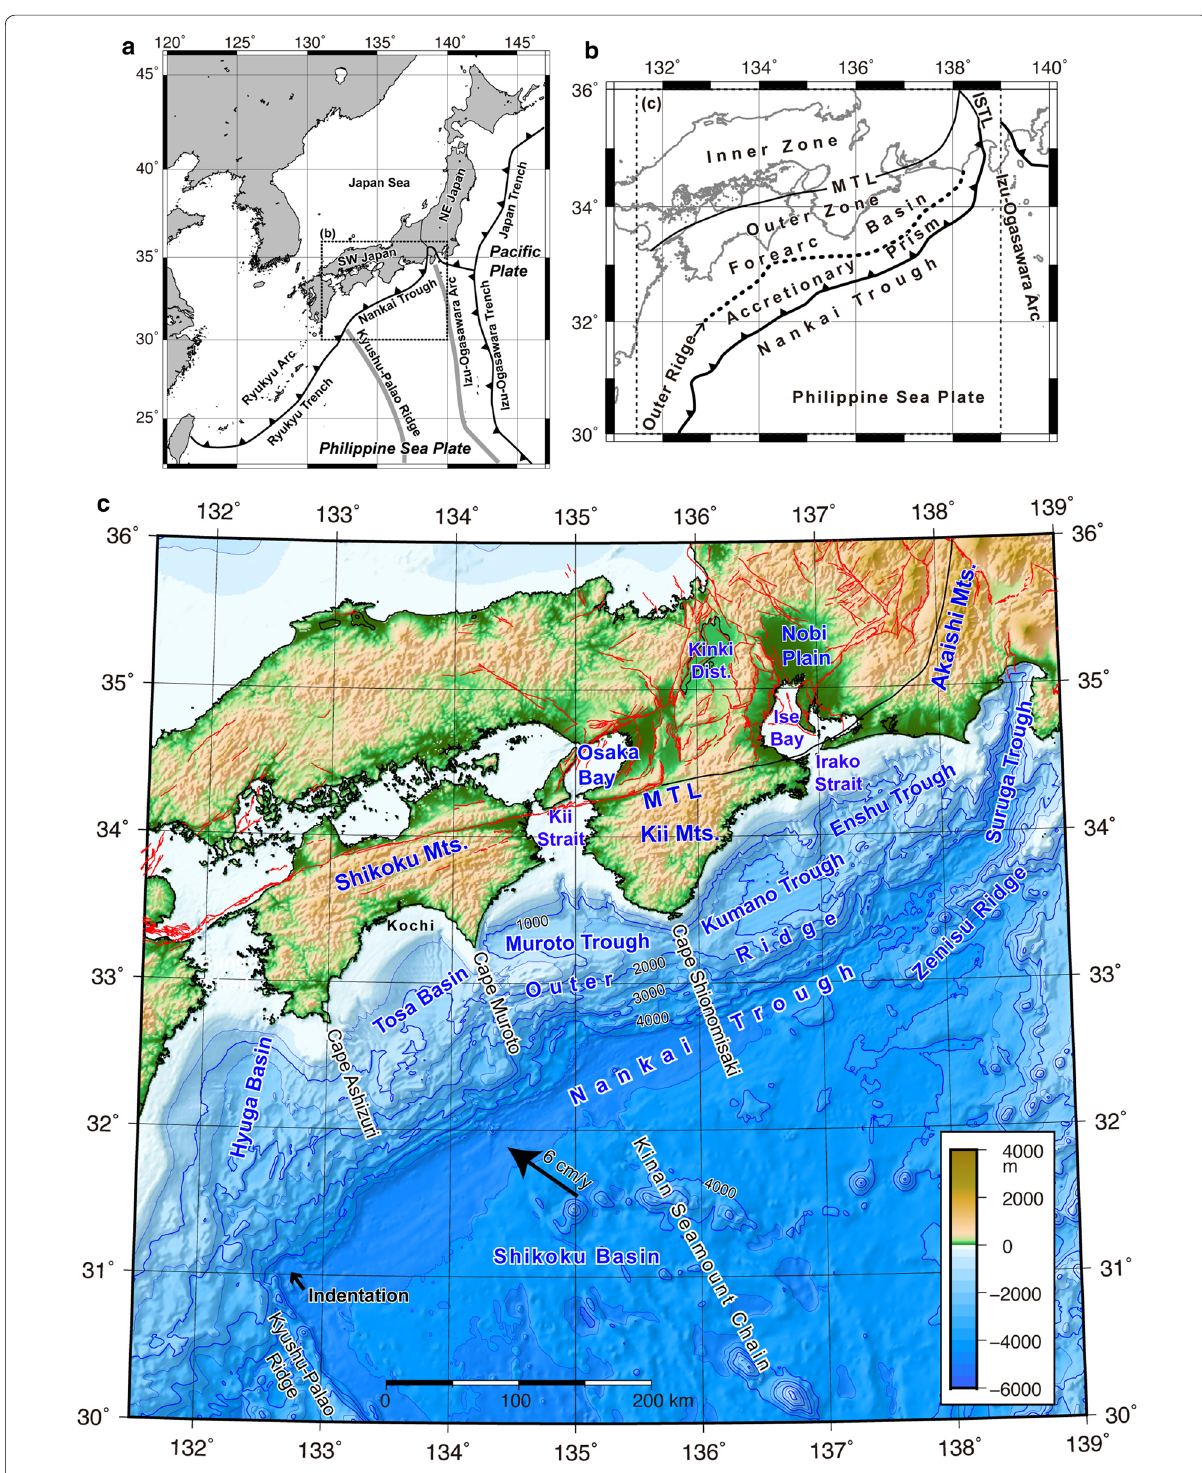
Fig. 1 Location and topography of the Suruga–Nankai Trough and Southwest Japan. a Location map and plate tectonic setting of the study area. b Tectonic zones of the southwestern Japan arc. MTL, Median Tectonic Line; ISTL, Itoigawa–Shizuoka Tectonic Line. c Shaded topography and bathymetry of Southwest Japan. Red lines are active faults modified from the Active Fault Database of the Geological Survey of Japan (https :// gbank .gsj.jp/activ efaul t/). The arrow shows the direction of plate